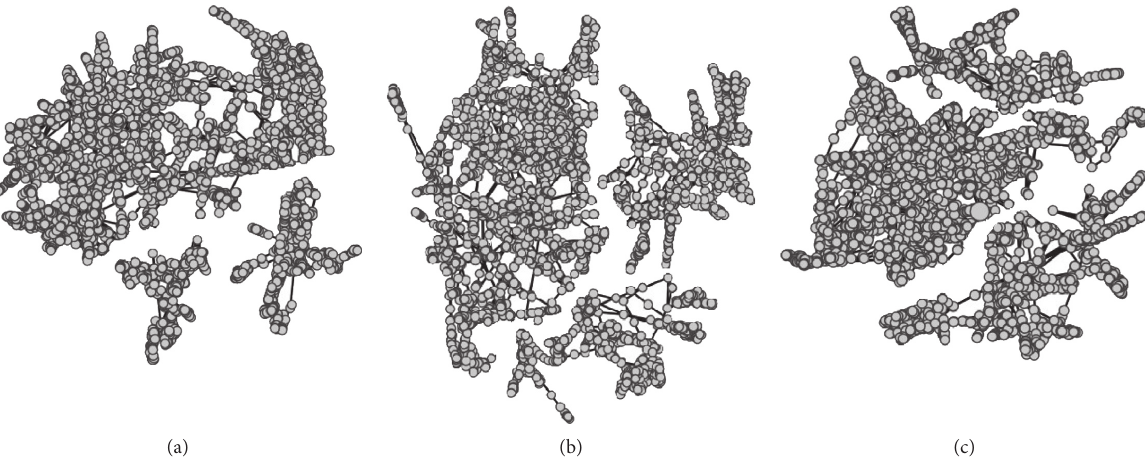
Figure 3: Graphs for the deaths, contagion, and suspect cases networks (after the rupture of the GC). (a) Deaths. (b) Contagion. (c) Suspect